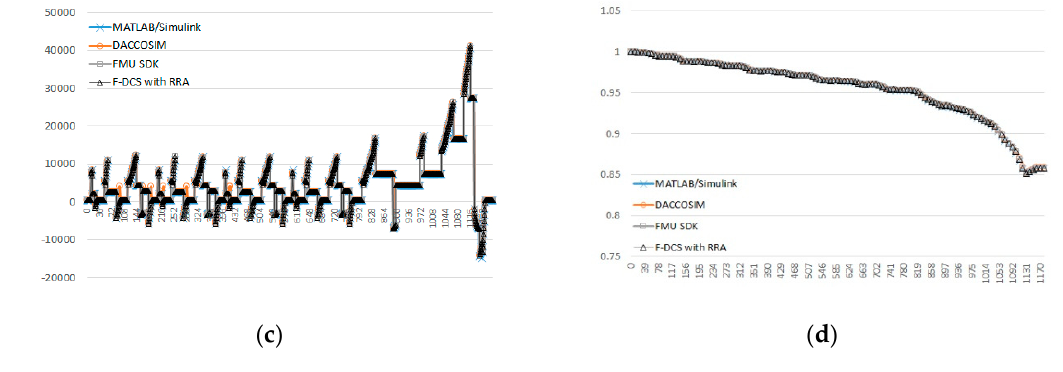
Figure 14. Results of EV simulation using driving cycle data; ( a ) Velocity ( m / s ) for time t , ( b ) tractive effort or force F t ( N ), ( c ) power consumption from the battery P bc (W), ( d ) SOC of the battery.